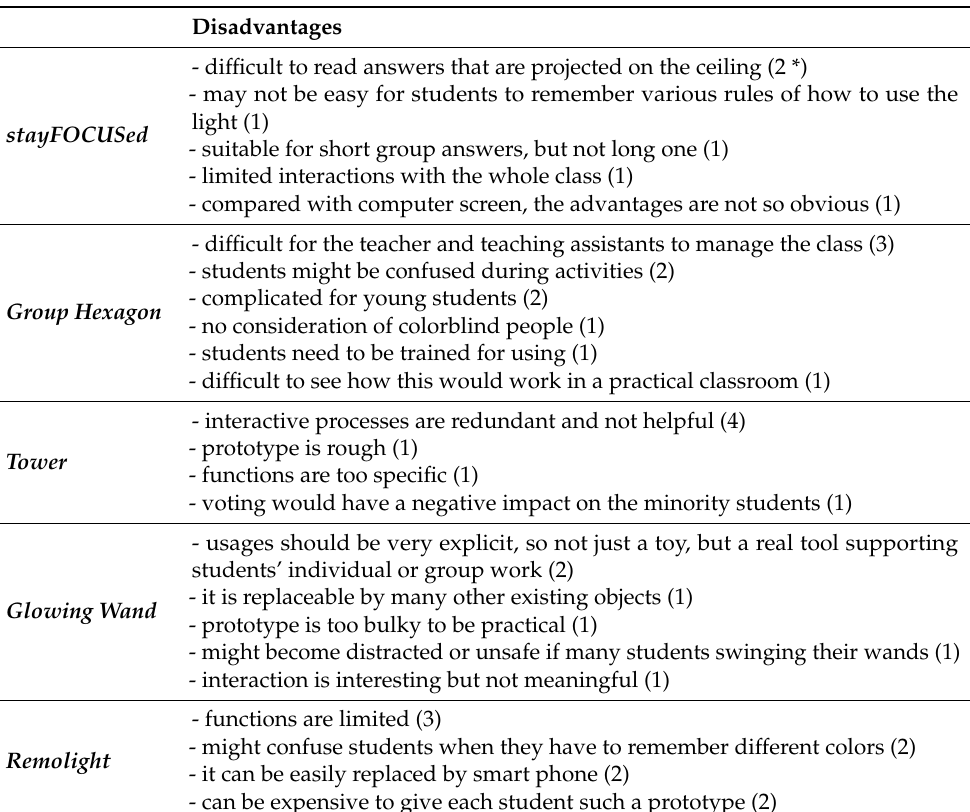
Table 6. Educational experts’ feedback on disadvantages of this study’s developed tangibles (* num- ber of comments